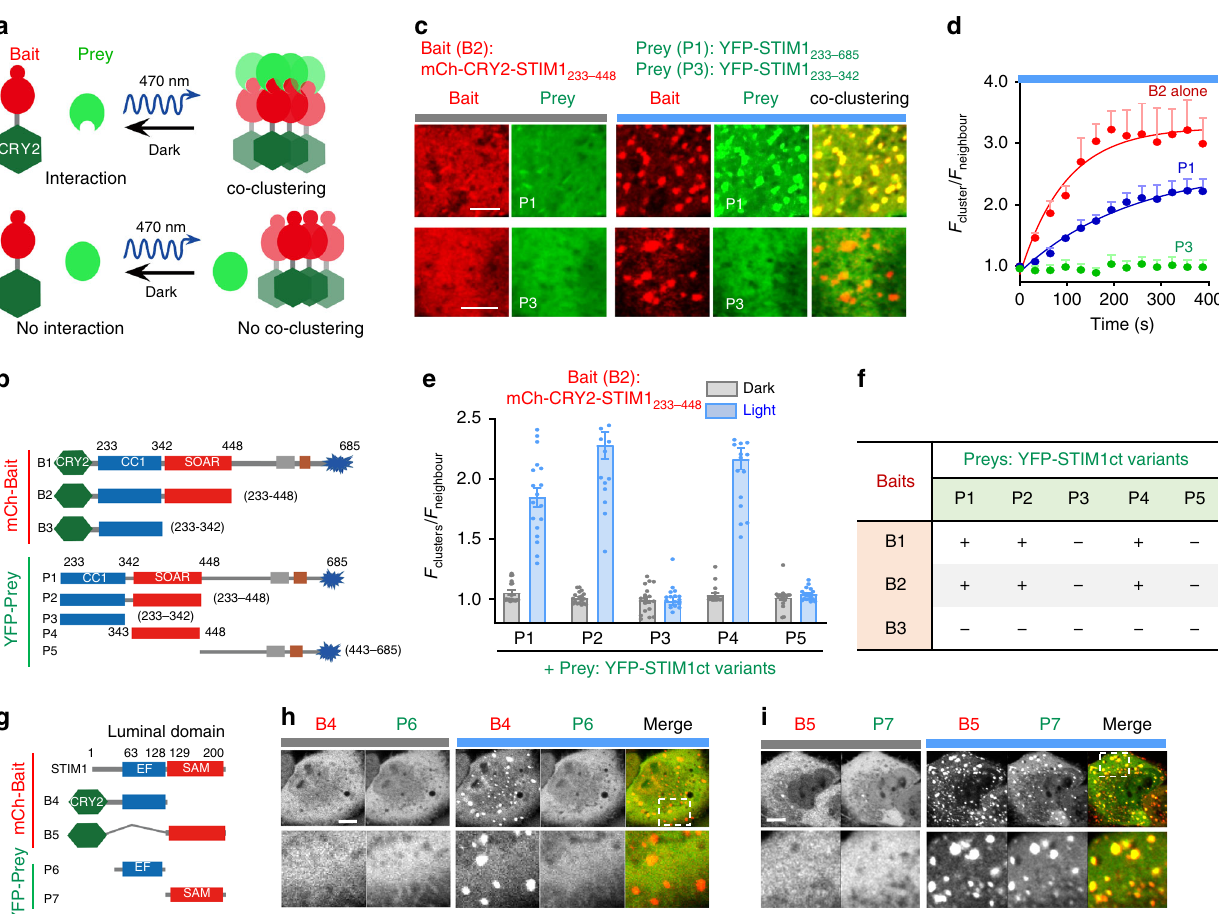
Fig. 4 An optogenetic clustering assay to dissect key determinants of STIM1 oligomerization. Data were shown as mean ± sem. Scale bar, 5 µ m. a Design of an optogenetic clustering assay to examine real-time protein – protein interactions in living cells. b Summary of mCh-tagged baits and YFP- tagged preys used to map critical domains in STIM1ct that dictate STIM1 oligomerization. c Representative confocal images showing the intracellular distribution of the bait (mCh-CRY2-STIM1 233 – 448 ) and two different preys (P1 — top panel, YFP-STIM1 233 – 658 ; P3 — bottom panel, YFP-STIM1 233 – 342 ) before and after blue light stimulation in HeLa cells. d Time courses showing the kinetics of light-induced clustering (F cluster /F neighbor ) of the bait and its co- clustering with P1 (blue), but not with P3 (green), as seen in panel c . n = 18 cells. ( e ) Quanti fi cation of the degrees of light-inducible co-clustering for the fi ve indicated preys in HeLa cells co-transfected with the bait. n = 18 cells from three independent experiments. f Summary of the optogenetic co-clustering assay results for the bait – prey combinations shown in panel b . “ + ” means co-clustering notably observed after photo-illumination; “ − ” means no appreciable cluster formation before and after blue light stimulation. g – i Light inducible co-clustering to dissect the STIM1 luminal EF-SAM domain. g Schematic showing the design of bait – prey constructs. h – i Representative confocal images of HeLa cells co-expressing ( h ) mCh-CRY2-EF (B4, STIM1 32 – 128, EF-hand ; red) with YFP-EF (P6, green), or ( i ) mCh-CRY2-SAM (B5, STIM1 128 – 200, SAM ; red) with YFP-SAM (P7; red) under dark (left) and blue light (right). The selected regions (dashed boxes) were enlarged to aid visualization. Scale bar 5 µ